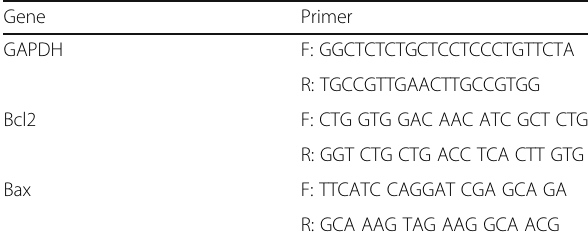
Table 1 Primers used for the amplification of the respective genes in the real-time quantitative reverse transcription polymerase chain reaction (qRT-PCR) Gene